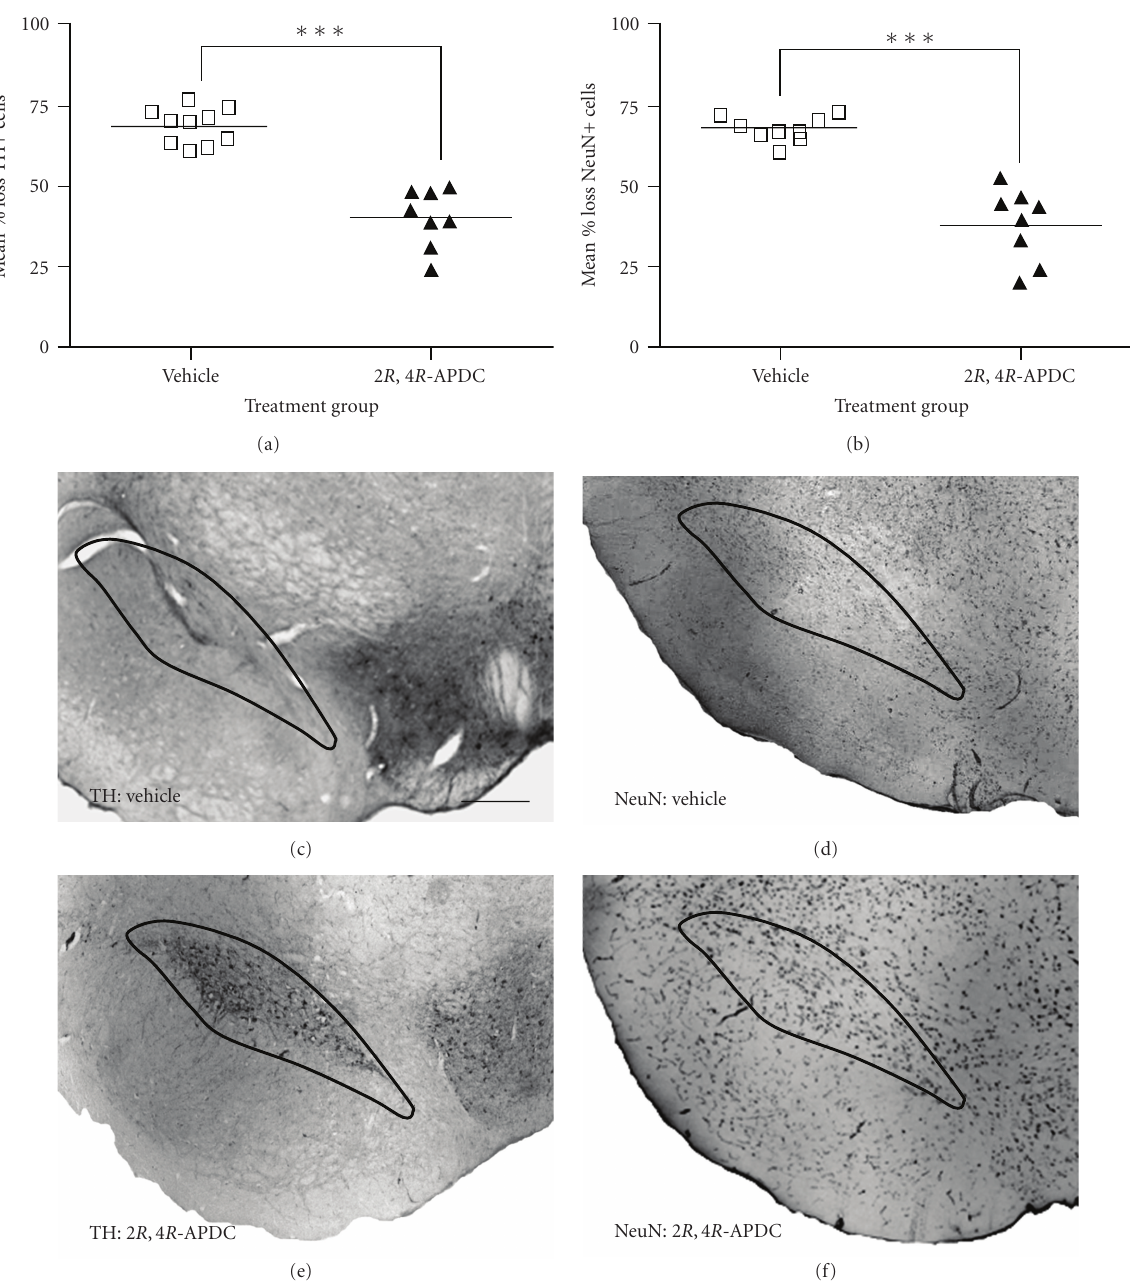
Figure 1: Delayed (48 hours post lesion) subchronic intranigral administration of 2 R ,4 R -APDC (10 nmol in 4 μ L) attenuates 6-OHDA toxicity in vivo. Scatter plots showing (a) the mean percentage loss ± s.e.m of nigral TH+ cells and (b) NeuN+ cells in each treatment group (Vehicle n = 10, 2 R ,4 R -APDC, n = 8). Note that 6-OHDA induces an equivalent reduction of both TH and NeuN+ cells in the SNc, which is significantly attenuated following delayed administration of 2 R ,4 R -APDC (10nmol). ∗∗∗ P < . 001, vehicle versus 2 R ,4 R -APDC (2-tailed students t -test). (c)–(f) Representative photomicrographs ( × 40) of DAB/peroxidase staining for TH and NeuN+ cells in the SNc from each treatment group, also showing the ROI encompassing the SNc used for cell counting, scale bar 200 μ m. (c) TH, 6-OHDA + vehicle, (d) NeuN,6-OHDA + vehicle, (e) TH, 6-OHDA + 2 R ,4 R -APDC, (f) NeuN, 6-OHDA + 2 R ,4 R